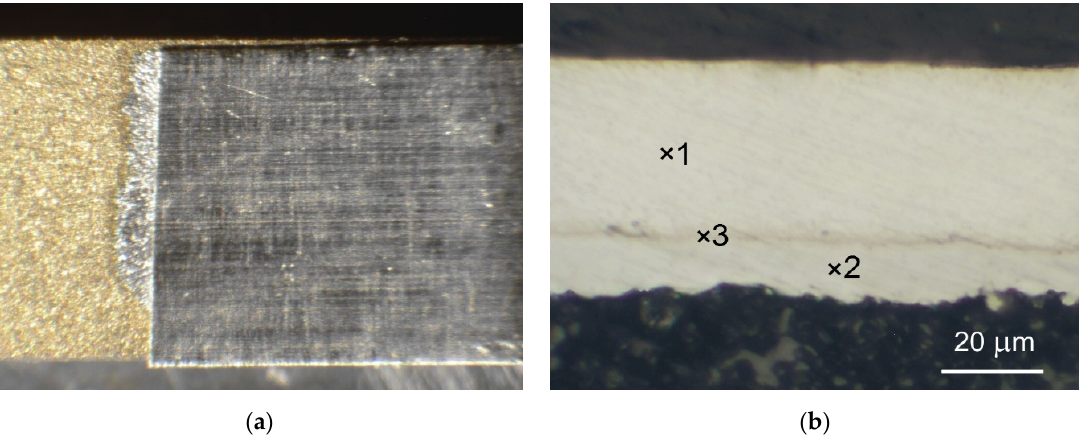
Figure 7. Microscopic pictures of a sample A: ( a ) overall view of joint; ( b ) cross-section of joint with phase composition of different areas: 1—Ag; 2—31.7 at.% Au, 68.3 at.% In; 3—65.8 at.% Ag, 34.2 at.% In.